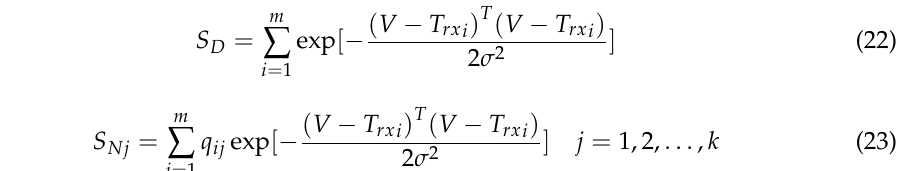
Figure 5. GRNN structure diagram. ( V is the input; y is the output; P m , S D and S N are node of neuron).